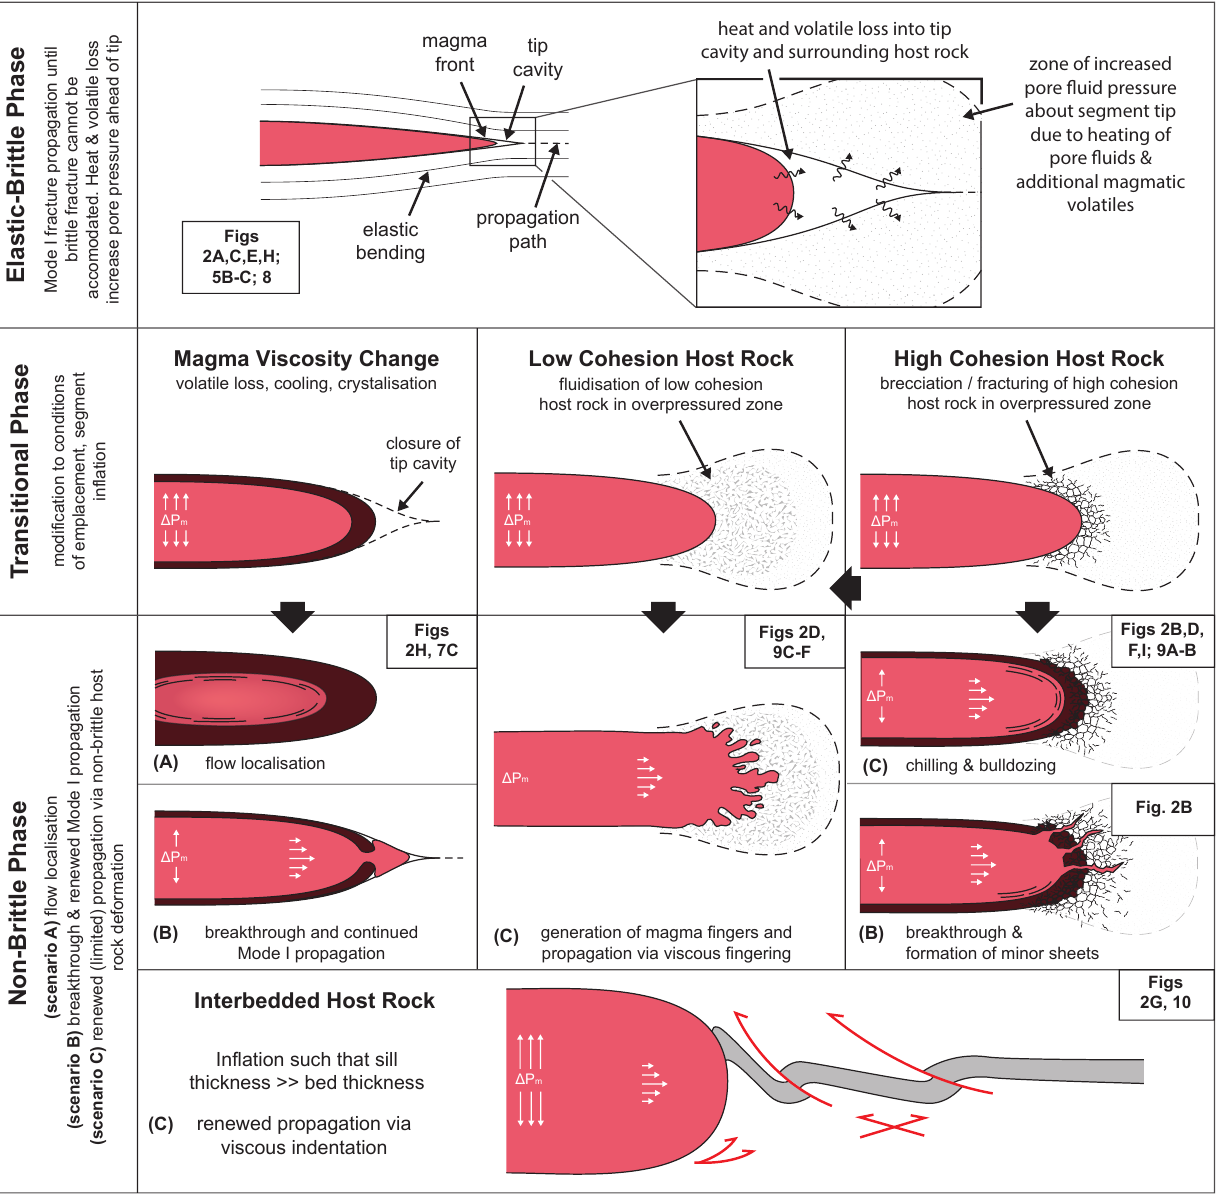
Figure 12: Conceptual model for evolution of collinear segments. [A] Stage I: Brittle propagation; [B] Stage II: local modification to the conditions of emplacement; driving pressure is accommodated predominantly by segment inflation. With increased fluid pressure, disaggregated (brecciated / fractured) high cohesion host rock could be- come fluidised, or disaggregated host may behave as a viscous medium. [C] Stage III: renewed limited propagation via non-brittle propagation